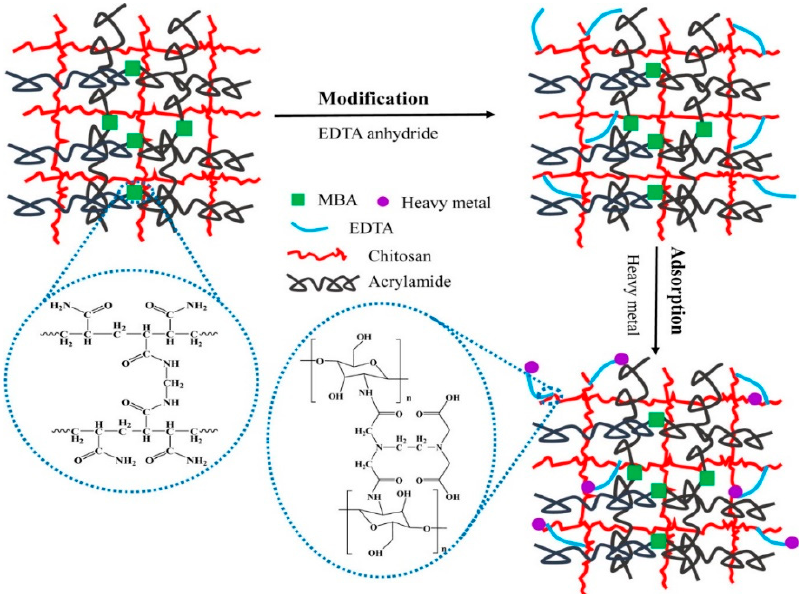
Figure 14. The proposed mechanism between chitosan/polyacrylamide hydrogel and heavy metal ions. (Reprinted from Ref. [115]. Copyright 2022 American Chemical Society).